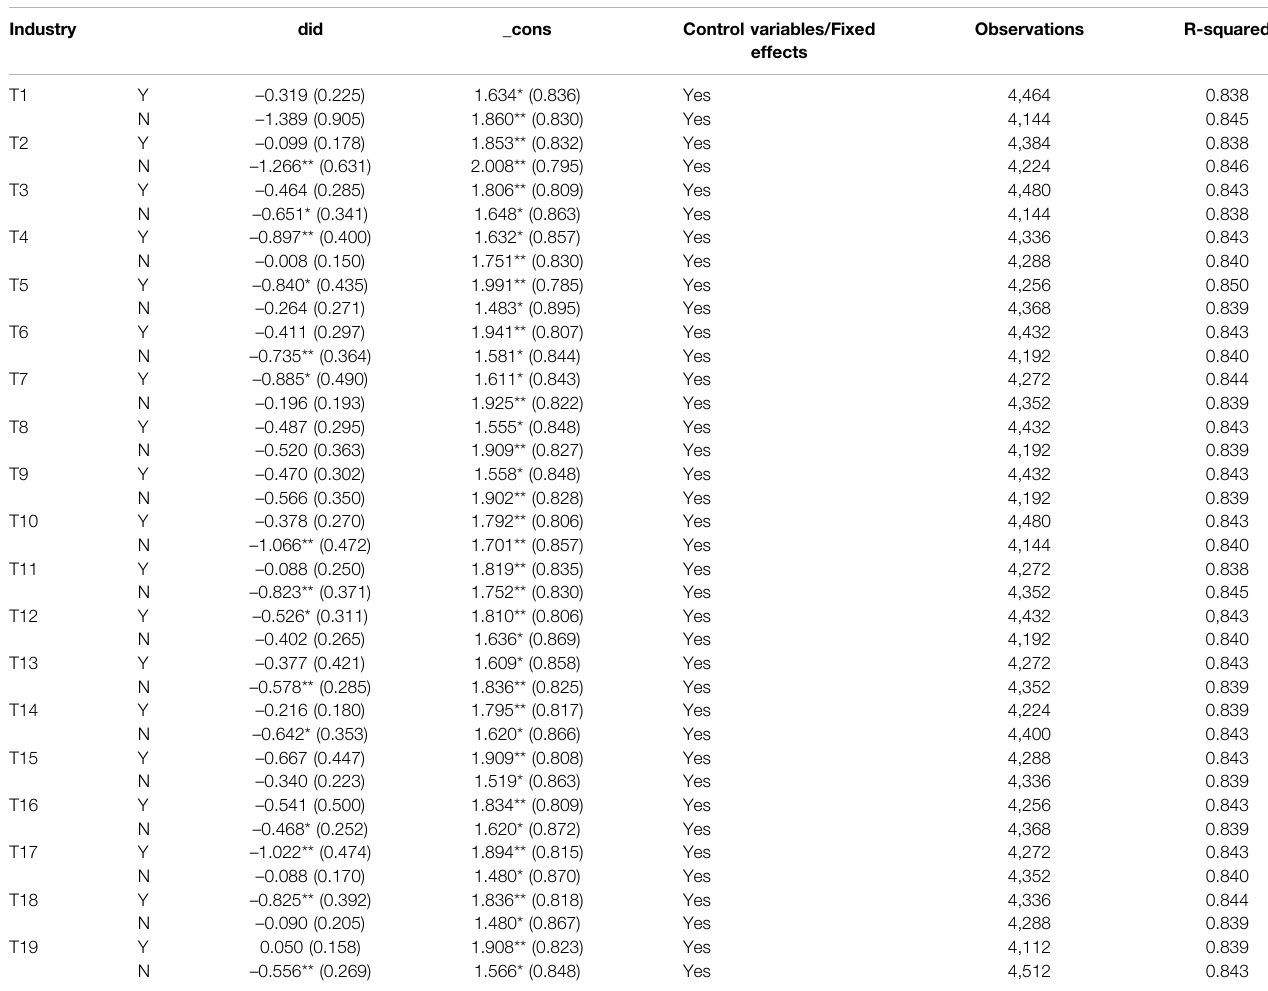
TABLE 7 | Focus of relocated industries based on air pollution. Industry